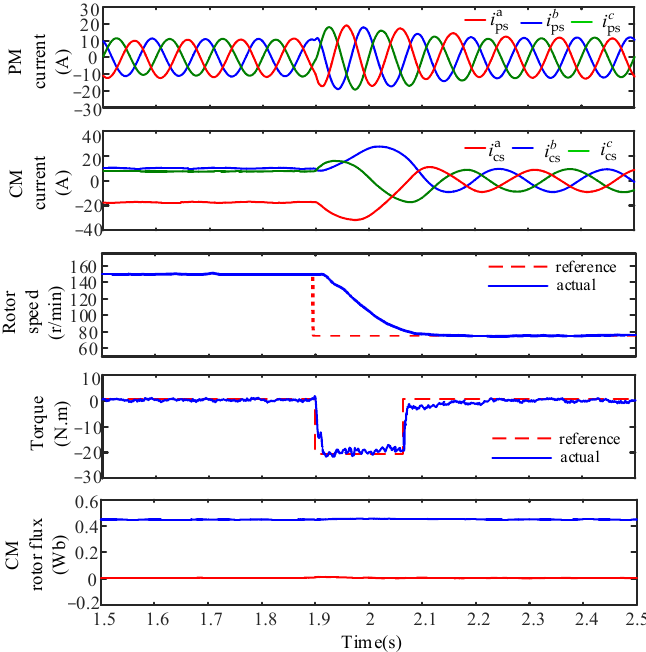
Figure 19. Experimental results of under-synchronization at 75 r/min.